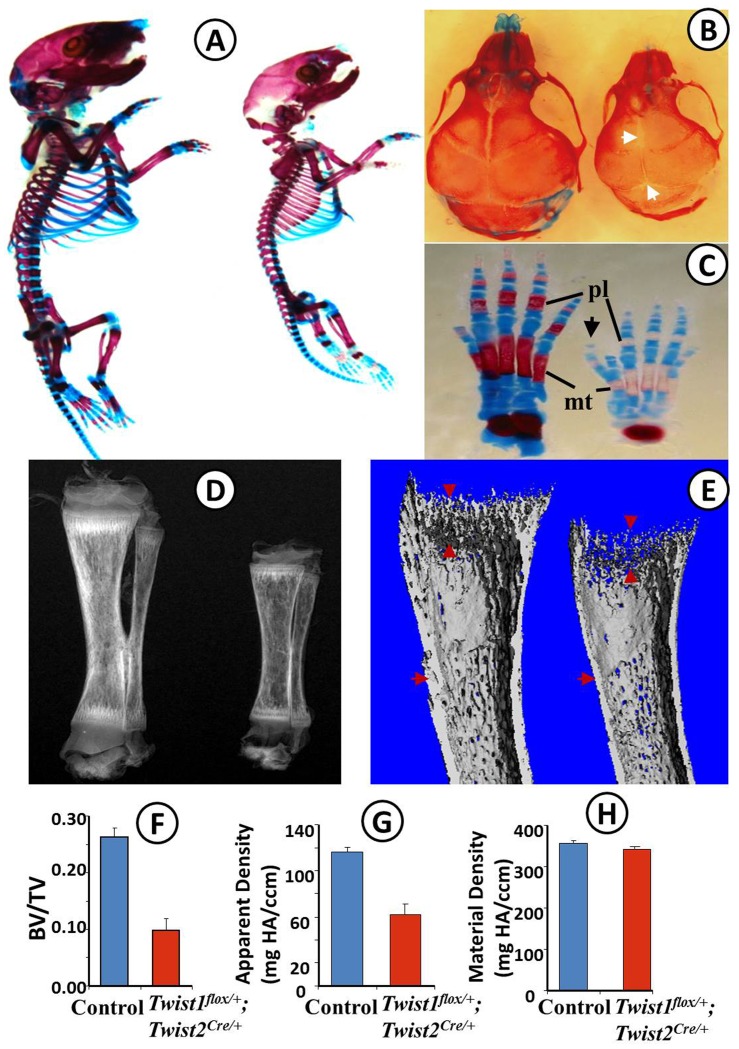
Reduced bone formation in Twist1flox/+; Twist2Cre/+ mice.(A) Skeletons of 6-day-old control (left) and Twist1flox/+; Twist2Cre/+ (right) mice stained with alcian blue (cartilage) and alizarin red (bone). The skeleton of the Twist1flox/+; Twist2Cre/+ mouse is remarkably smaller. (B) Alcian blue- and alizarin red-stained skull from 6-day-old Twist1flox/+; Twist2Cre/+ mice (right) showed delayed fusion of interfrontal suture and open posterior fontanel (arrows), compared with the control mice (left). (C) Alcian blue- and alizarin red-stained hind foot of 6-day-old control (left) and Twist1flox/+; Twist2Cre/+ (right) mice. Note the delayed ossification in metatarsals (mt) and phalanges (pl), and an additional toe (arrow) originating from the same (or duplicated) metatarsal as the hallux in Twist1flox/+; Twist2Cre/+ mice. (D) Plain X-radiography of the tibiae from 6-day-old control (left) and Twist1flox/+; Twist2Cre/+ mice (right). The Twist1flox/+; Twist2Cre/+ mice had shorter tibiae and reduced radiopacity, compared to the control mice. (E) Representative three-dimensional μ-CT images of tibiae from 6-day-old control (left) and Twist1flox/+; Twist2Cre/+ (right) mice. The Twist1flox/+; Twist2Cre/+ mice showed reduced trabecular (arrowheads) and cortical bones (arrows). (F–H) Quantitative μ-CT data showing that the 6-day-old Twist1flox/+; Twist2Cre/+ mice had a significant decrease in the ratio of bone volume (BV)/total volume (TV) (F) and in apparent bone density (G), compared to the control mice (n = 6, P<0.001). The Twist1flox/+; Twist2Cre/+ mice also presented reduced material density although no statistically significant difference was observed (H).